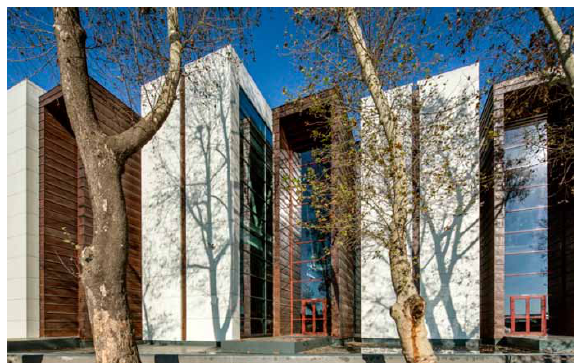
fig. 15. Istanbul naval Museum – view from seaside (www.arkitera.com)